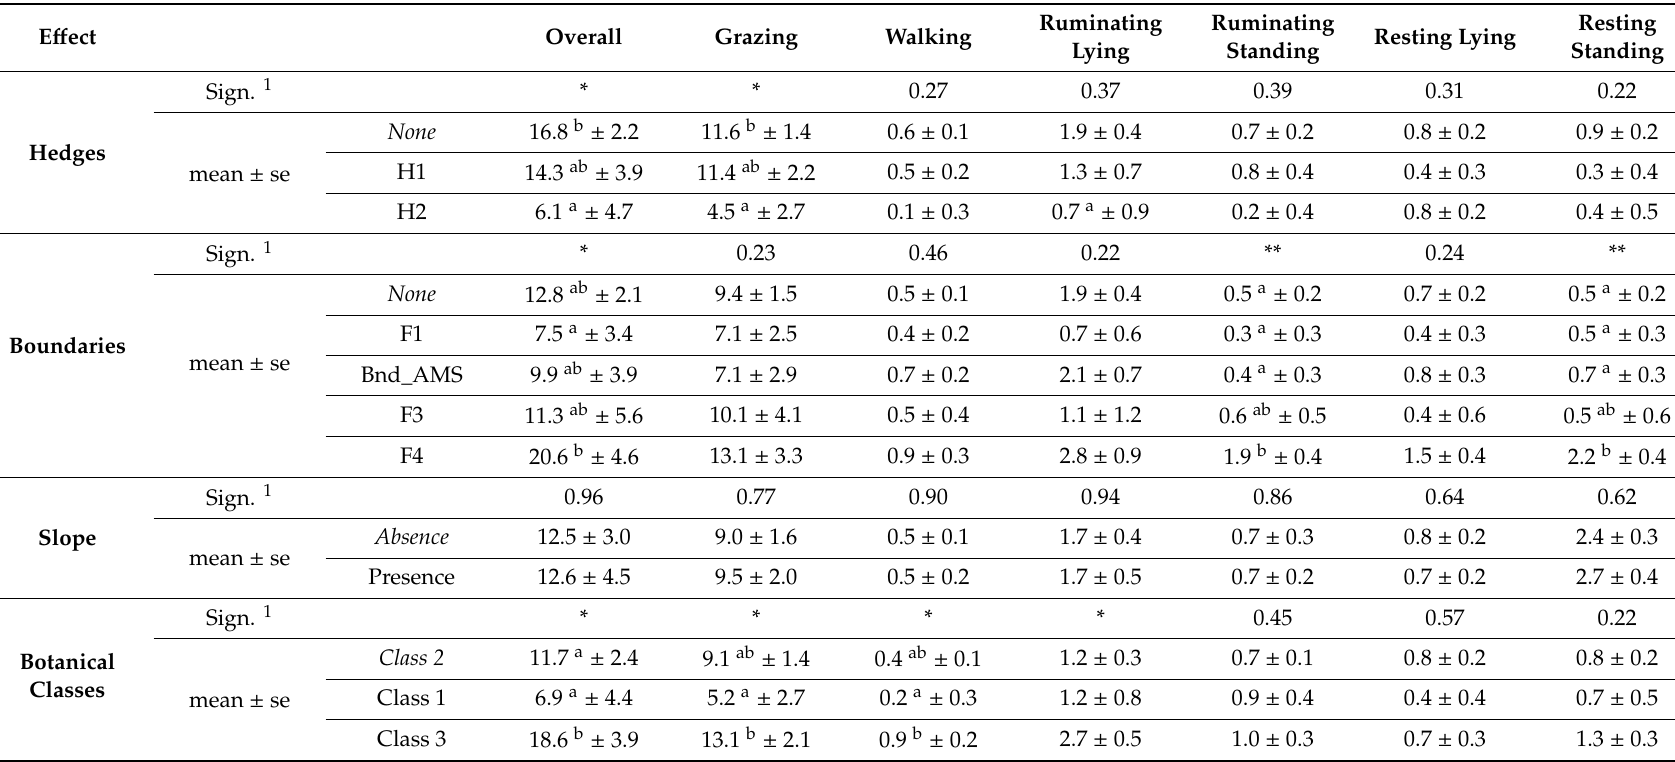
Table 3. E ff ect of the pasture characteristics on the overall cow location and time-budget expressed in seconds per surface unit of 8 m × 8 m, per cow and per day in the temporary grassland.